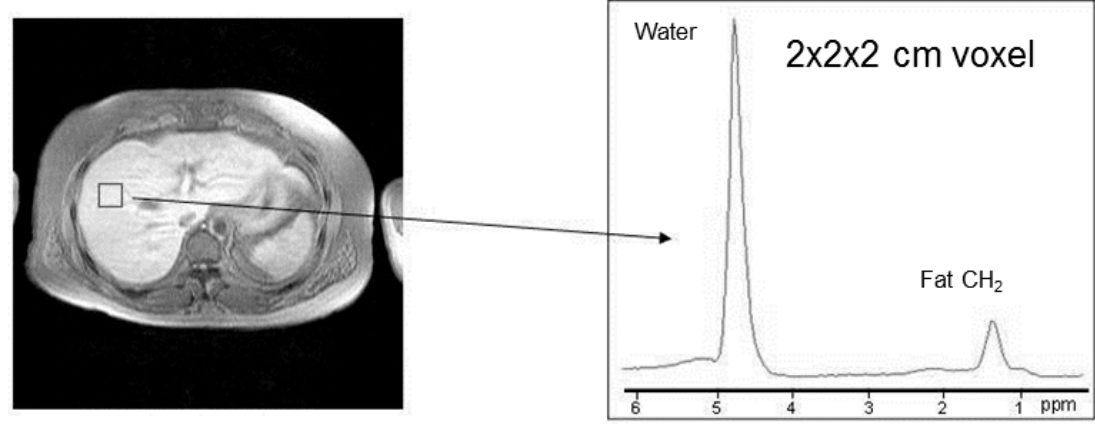
Figure 1. Transverse magnetic resonance (MR) image through the abdomen and localised MR spectrum recorded from the 2 × 2 × 2 cm voxel placed over the liver. The frequency axis of the spectrum is expressed in parts per million (ppm).